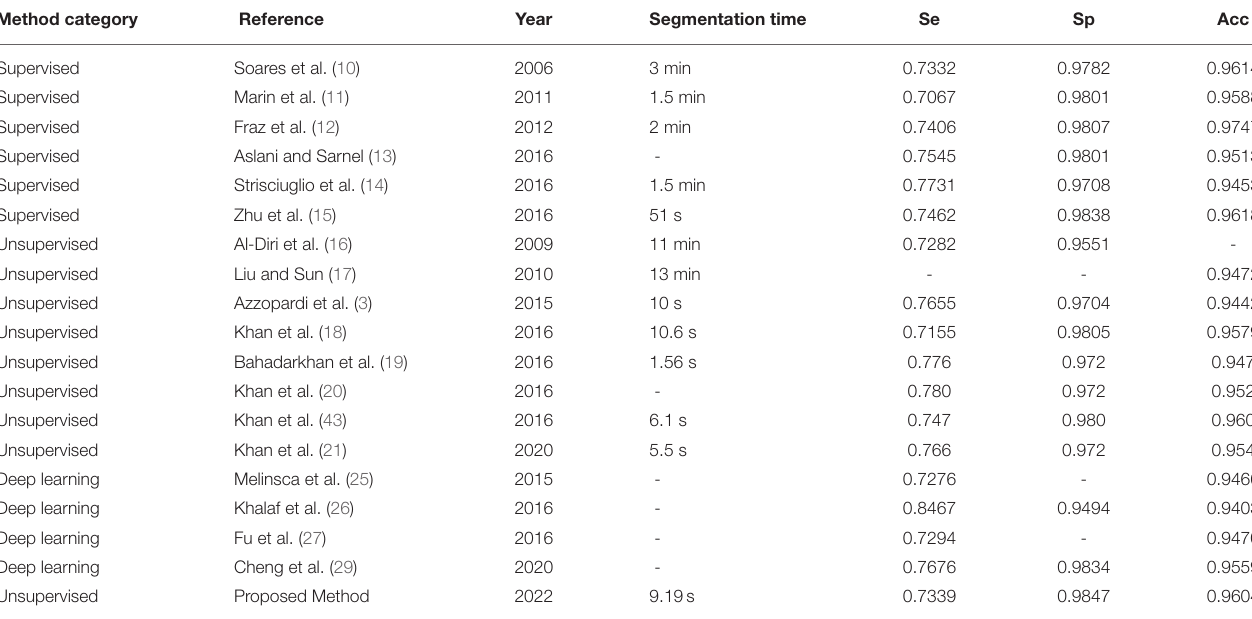
TABLE 6 | Comparison with other methods